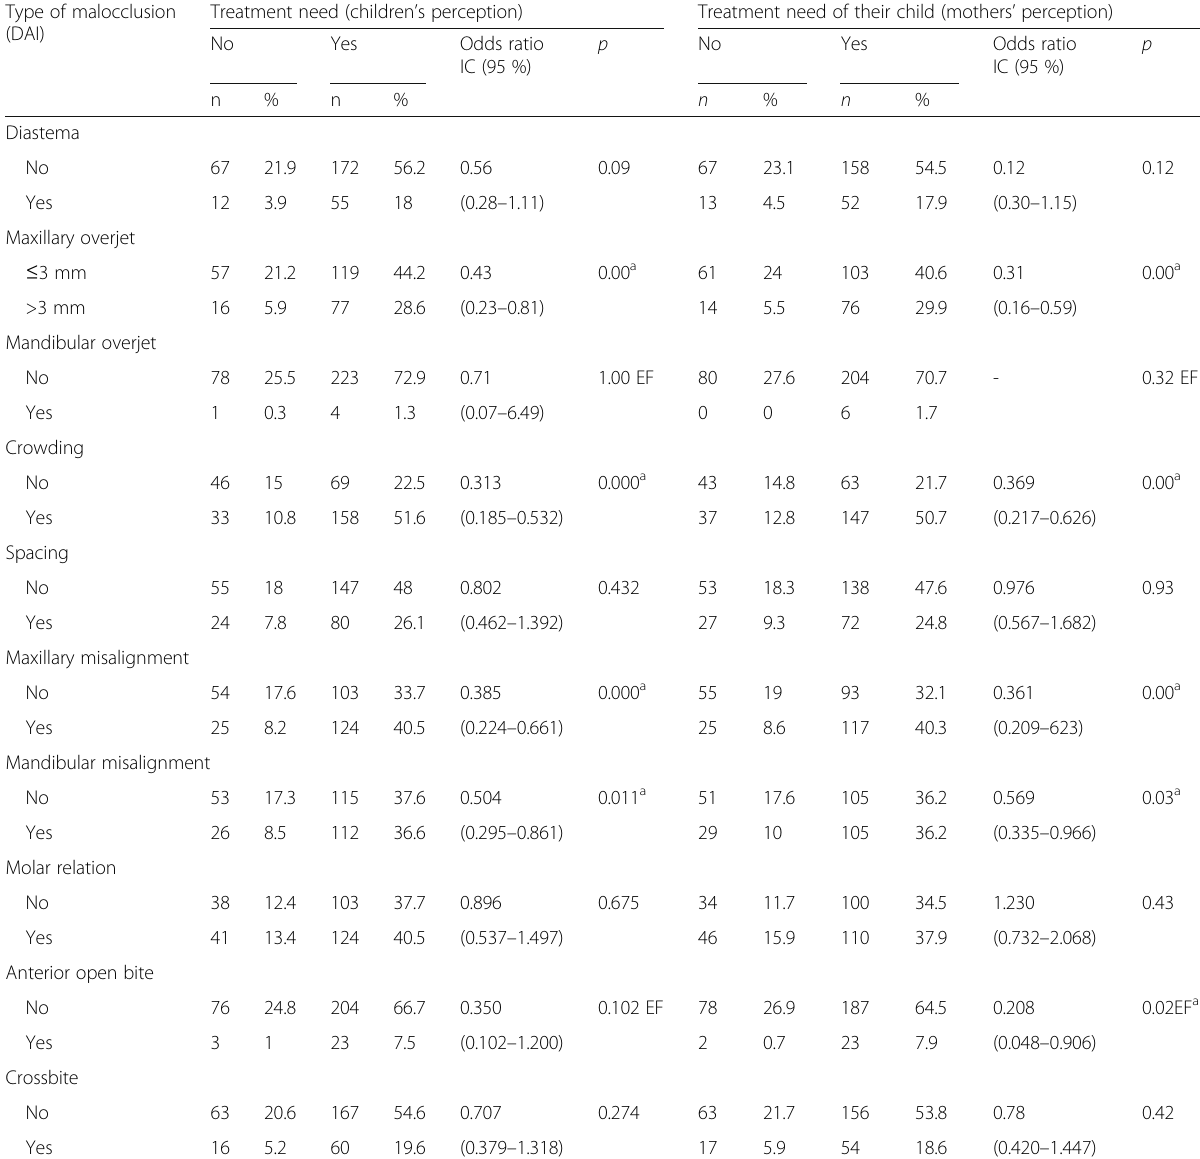
Table 1 Association between type of malocclusion and perceived orthodontic treatment need in 12-year-old children and their mothers Type of malocclusion